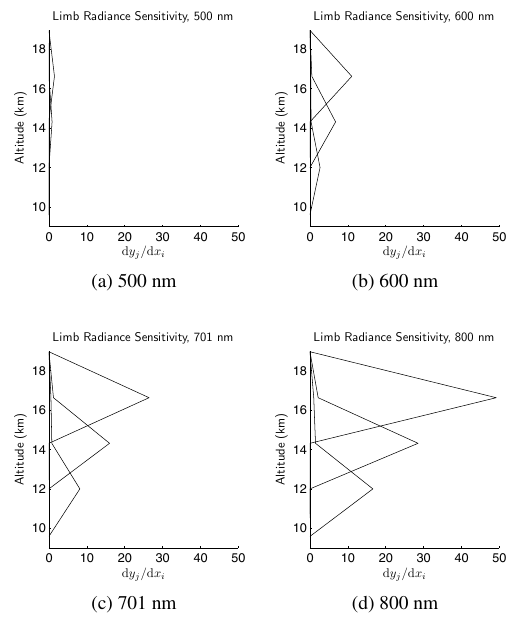
Fig. 12: Kernel matrix for selected wavelengths for scattering by 50 µ m particles. 50µm